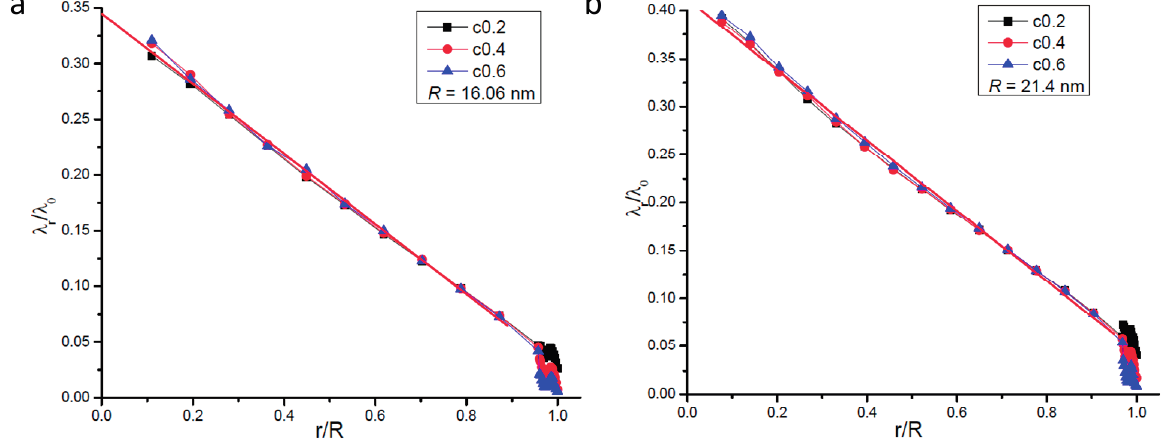
Figure 3. Variation of radial gas molecular mean free path with the distance from the center of the nanopore; the line represents the fitting results. ( a ) R = 16.06 nm; ( b ) R = 21.4 nm; and ( c ) R = 32.0